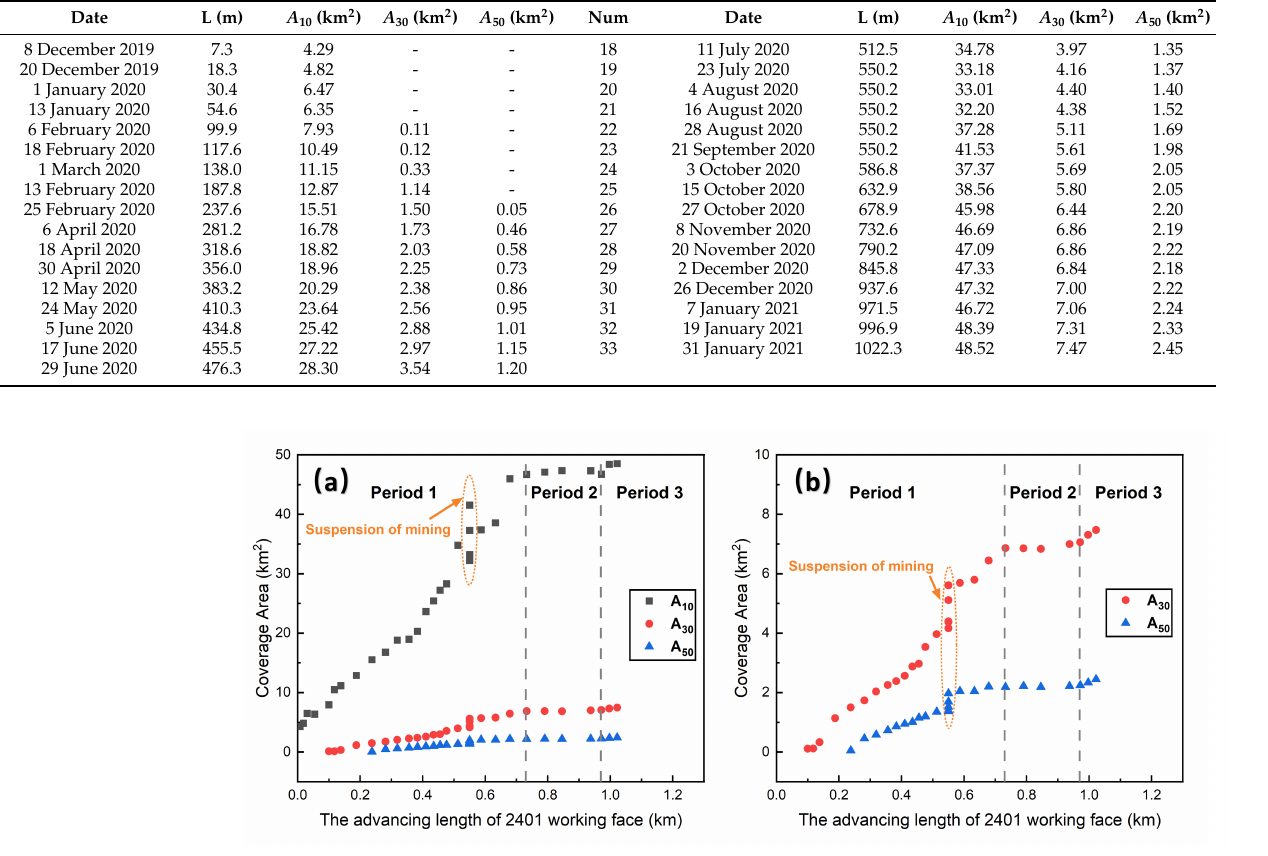
Figure 13. Relationship between coverage area of the surface subsidence basin and advancing length of the 2401 working face. ( a ) Coverage area of subsidence value over 10 mm. ( b ) Coverage area of subsidence value over 30 and 50